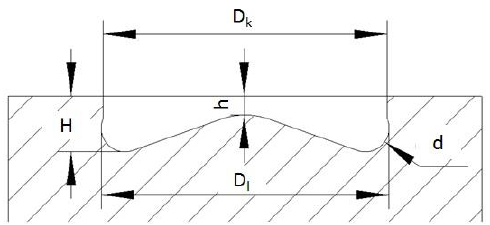
Figure 1. Geometric parameters of the combustion chamber. Table 1. Comparison of the geometric parameters of combustion chambers.